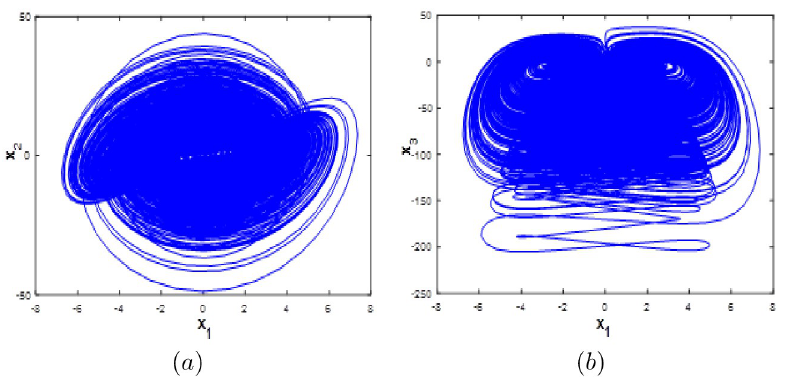
Fig 17. Phase portraits of the hyperchaotic system (17): (a) x 1 − x 2 attractor, (b) x 1 − x 3 attractor.